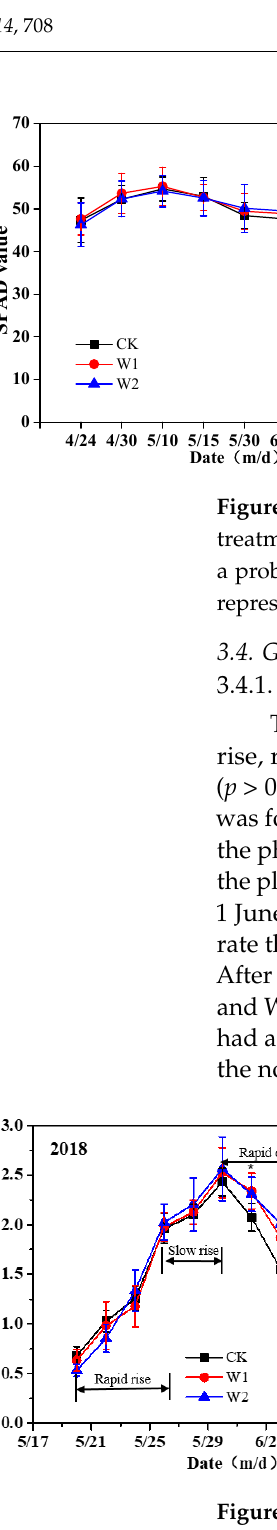
Figure 8. Grain filling rate during the grain filling stage under different treatments in 2018 and 2019. The values are the mean ± standard error ( n = 3). * = significant at a probability level of p < 0.05